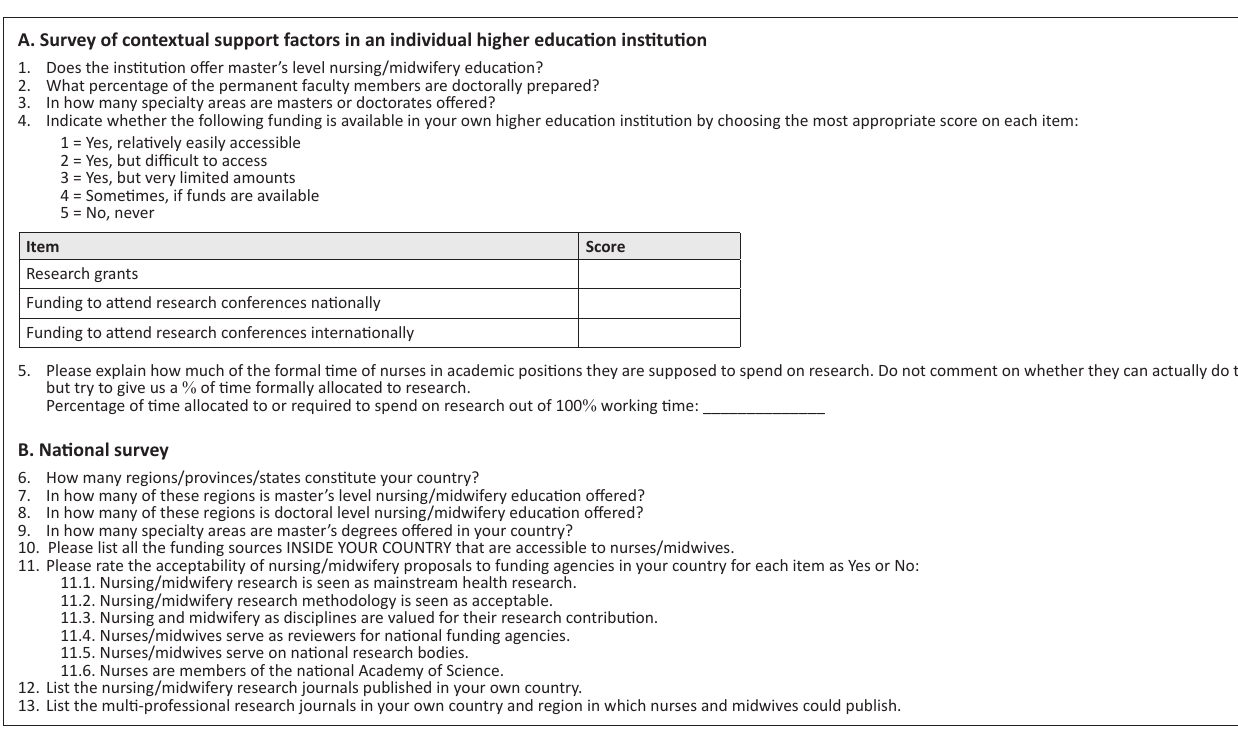
FIGURE 1: Survey instrument assessing institutional and national contextual support for nursing research in a